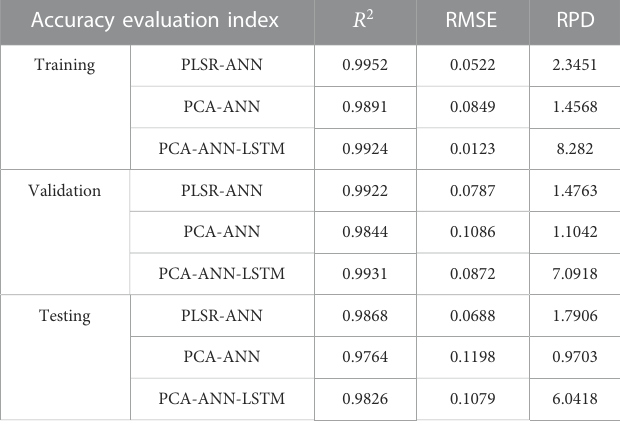
TABLE 1 Comparison of the SVD-PCA-ANN model with SAE, SVM, and LSTM. Accuracy evaluation